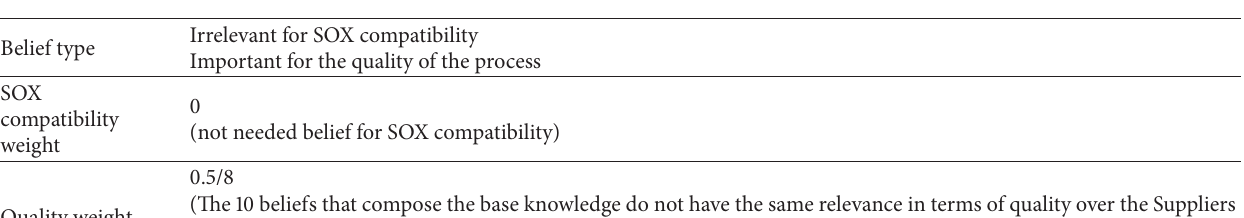
Table 4: RFI Scoring